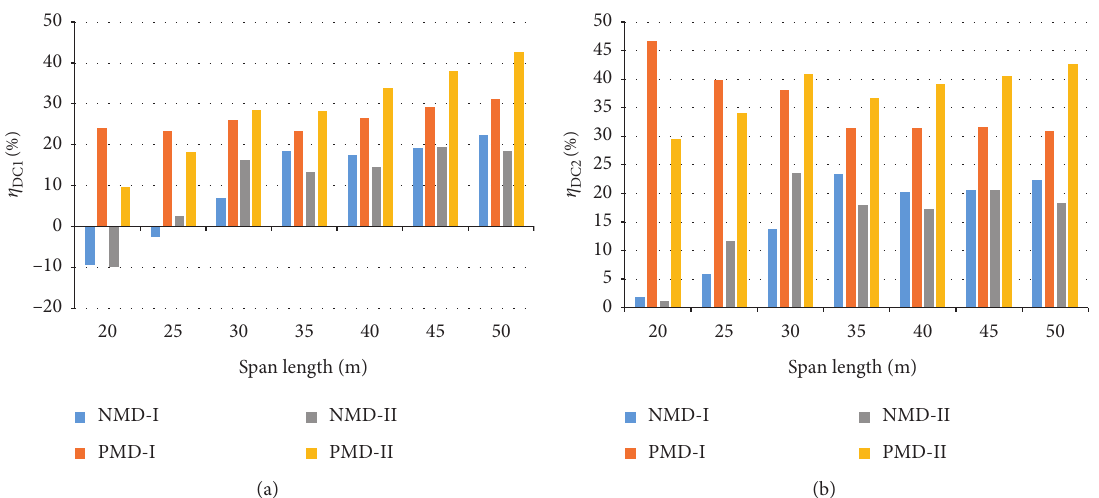
Figure 9: Comparison of the traffic loading effects of three-span continuous girder bridges with the dynamic load allowance: (a) η (b) η DC2 .